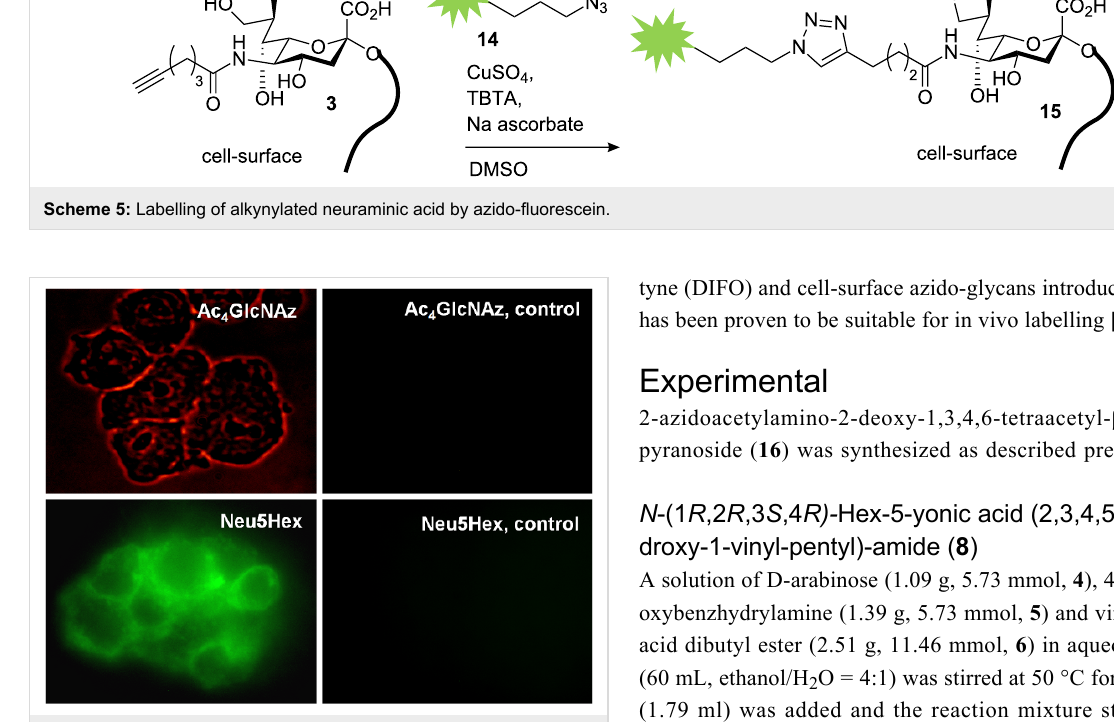
Figure 1: Top left: HEp-2 cells incorporated with Ac 4 GlcNAz 16, labelled with alkynylated TAMRA at 580 nm. Bottom left: HEp-2 cells with incorporated NeuNHex 3 , labelled with azido-fluorescein 14 , at 525 nm. On the right: background and unspecific staining controls at the same wavelengths as the corresponding pictures on the